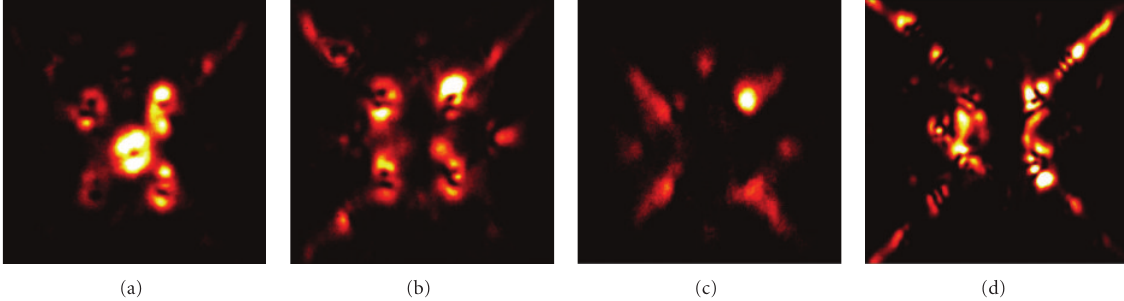
Figure 8: Experimental results of SCV beam output after propagating through (a) a half-intensity ( I d /I c = 1 / 1) defect and (b) a zero- intensity defect at a fixed bias field of 2.6 kV/cm. (c), (d) Output of the vortex beam through the zero-intensity defect when the bias field is decreased to 1.4 kV/cm and increased to 3.2kV/cm, respectively.